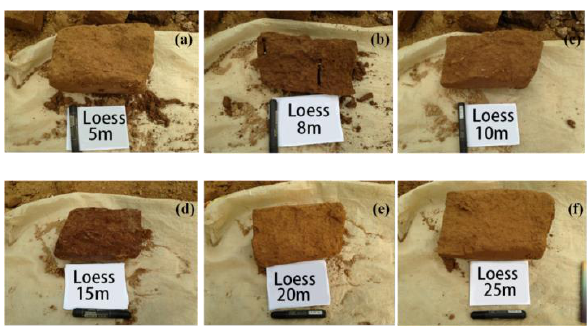
Figure 3. Loess samples with di ff erent depths, ( a ) 5 m depth, ( b ) 8 m depth, ( c ) 10 m depth, ( d ) 15 m depth, ( e ) 20 m depth, and ( f ) 25 m